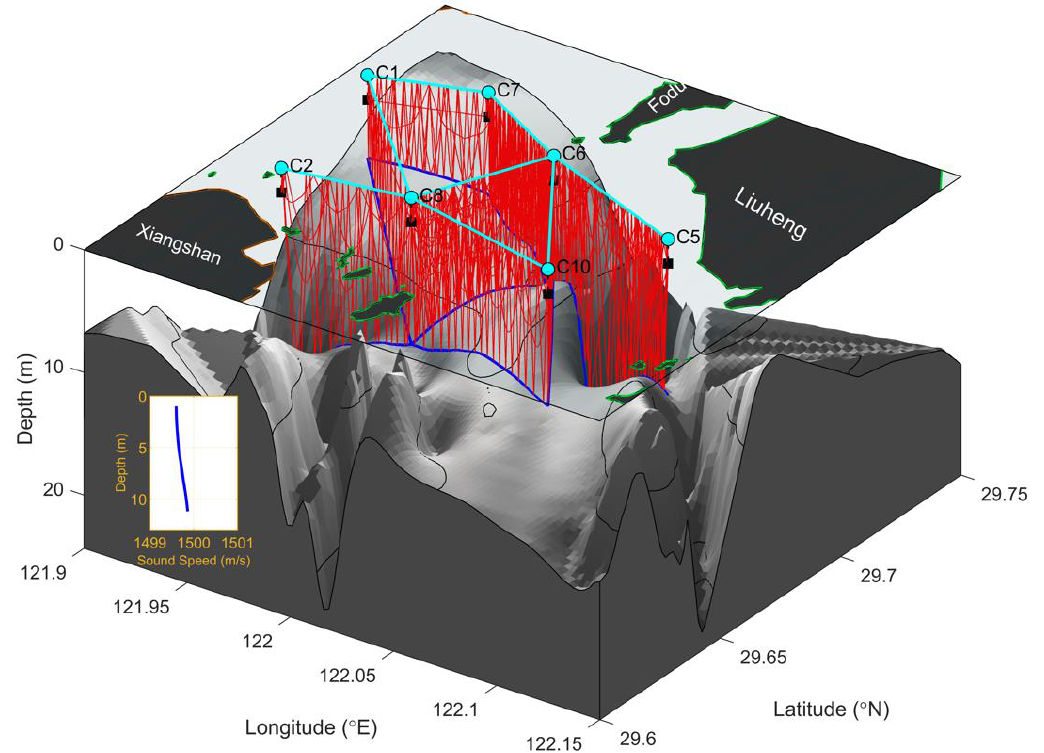
Figure 3. Acoustic ray tracing simulation in XSB. Red lines indicate the propagation paths of acoustic signals along the CAT sections. Blue and cyan lines indicate the sea bottom and sea surface, respectively. Black squares indicate the location of the transducers. The sound speed profile (thick blue line) is plotted in the bottom left